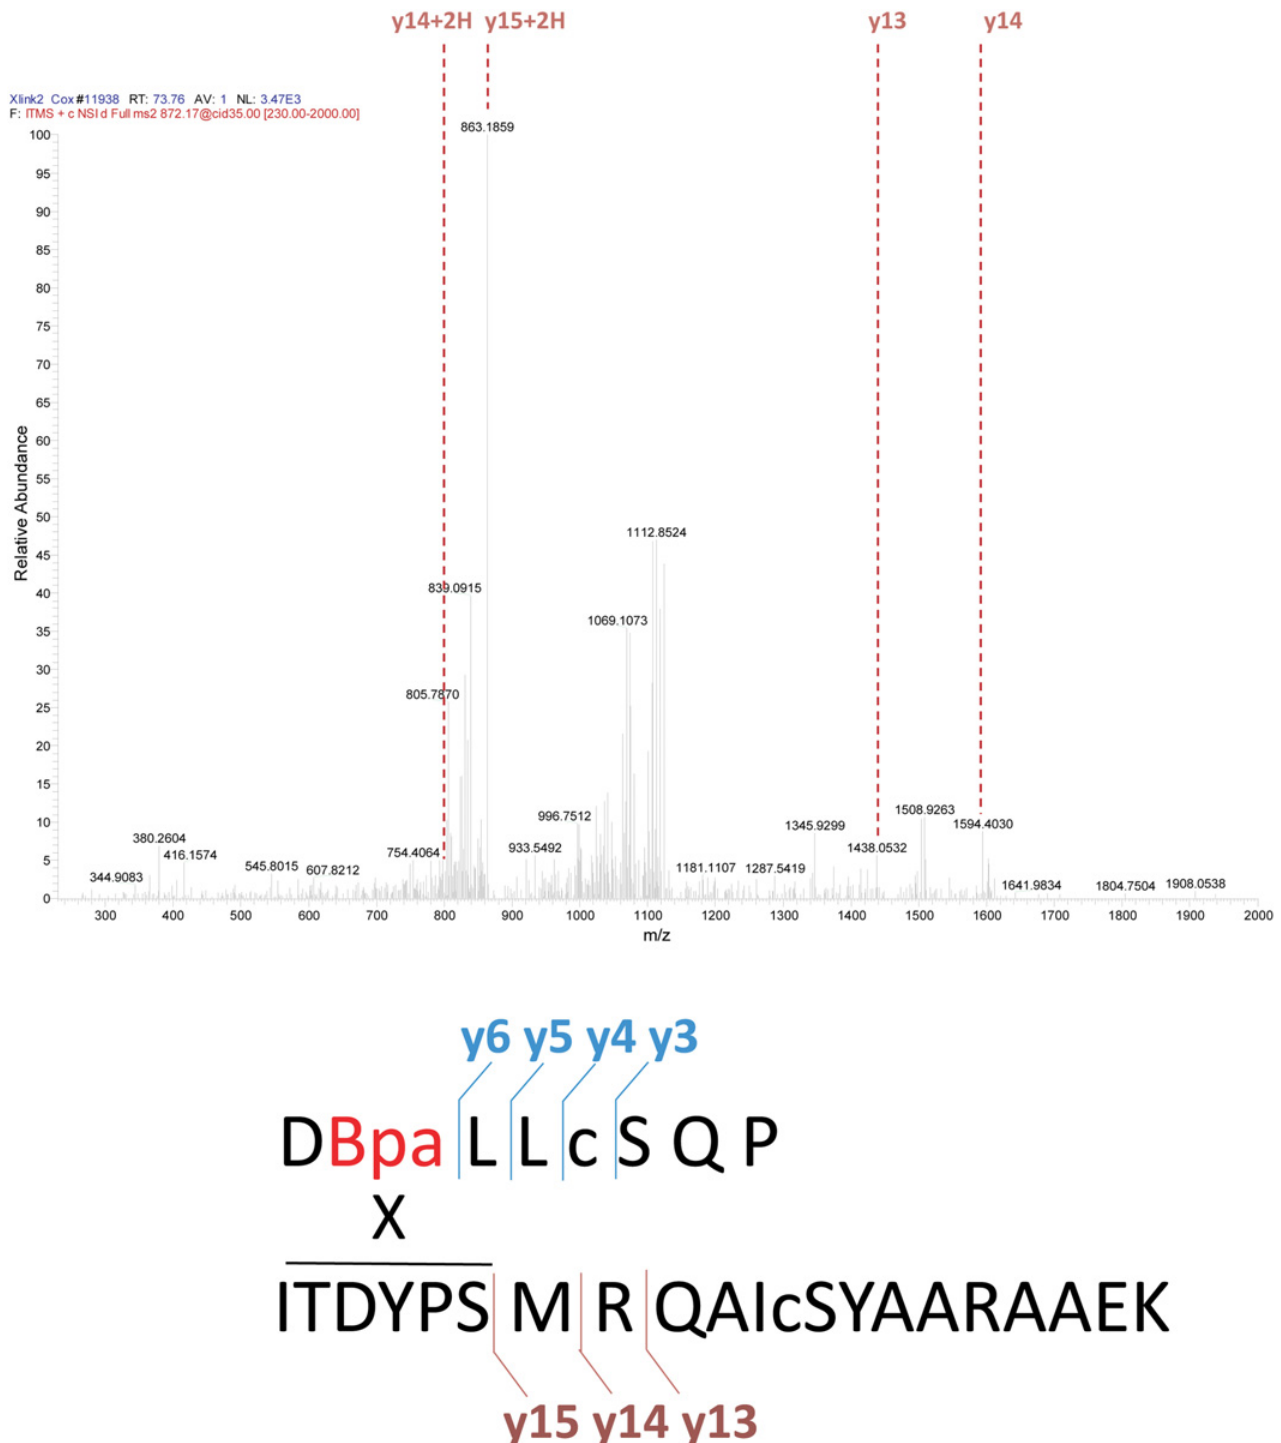
Fig 14. Analysis of cross-linked RecA-UmuC product #2. The second of the two identified cross-linked products appeared primarily in the samples generated via the active pol V Mut protocol, and involved crosslinking between the RecA 113Bpa residue and a peptide spanning residues 256 – 276 in UmuC. MS/MS spectrum for the RecA-UmuC cross-linked product is shown at the top, with the predicted cross-linking location (the six amino acid residues at the N-terminus, residues 256 – 261 in UmuC) shown at the